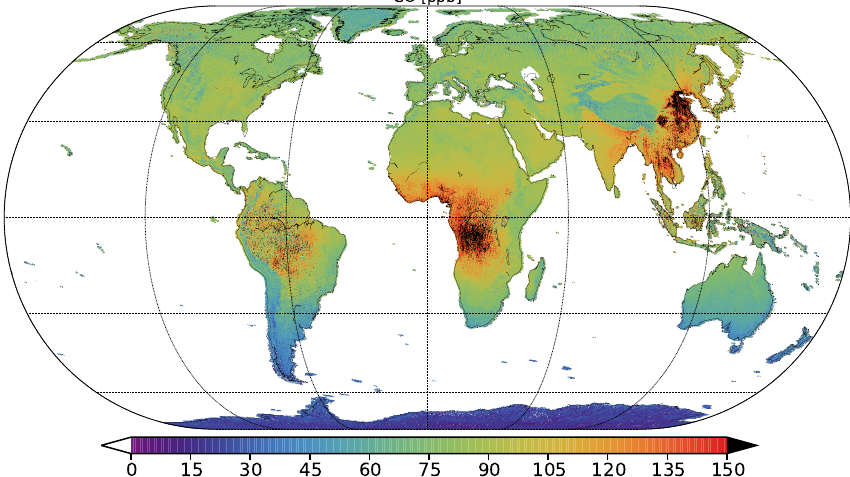
Figure 11. CO wet air column averaged mixing ratios over land and clear-sky scenes. The values are averaged from January 2003 to April 2012 on a cylindrical equal area projection with 180 grid points in latitude and 360 in longitude.